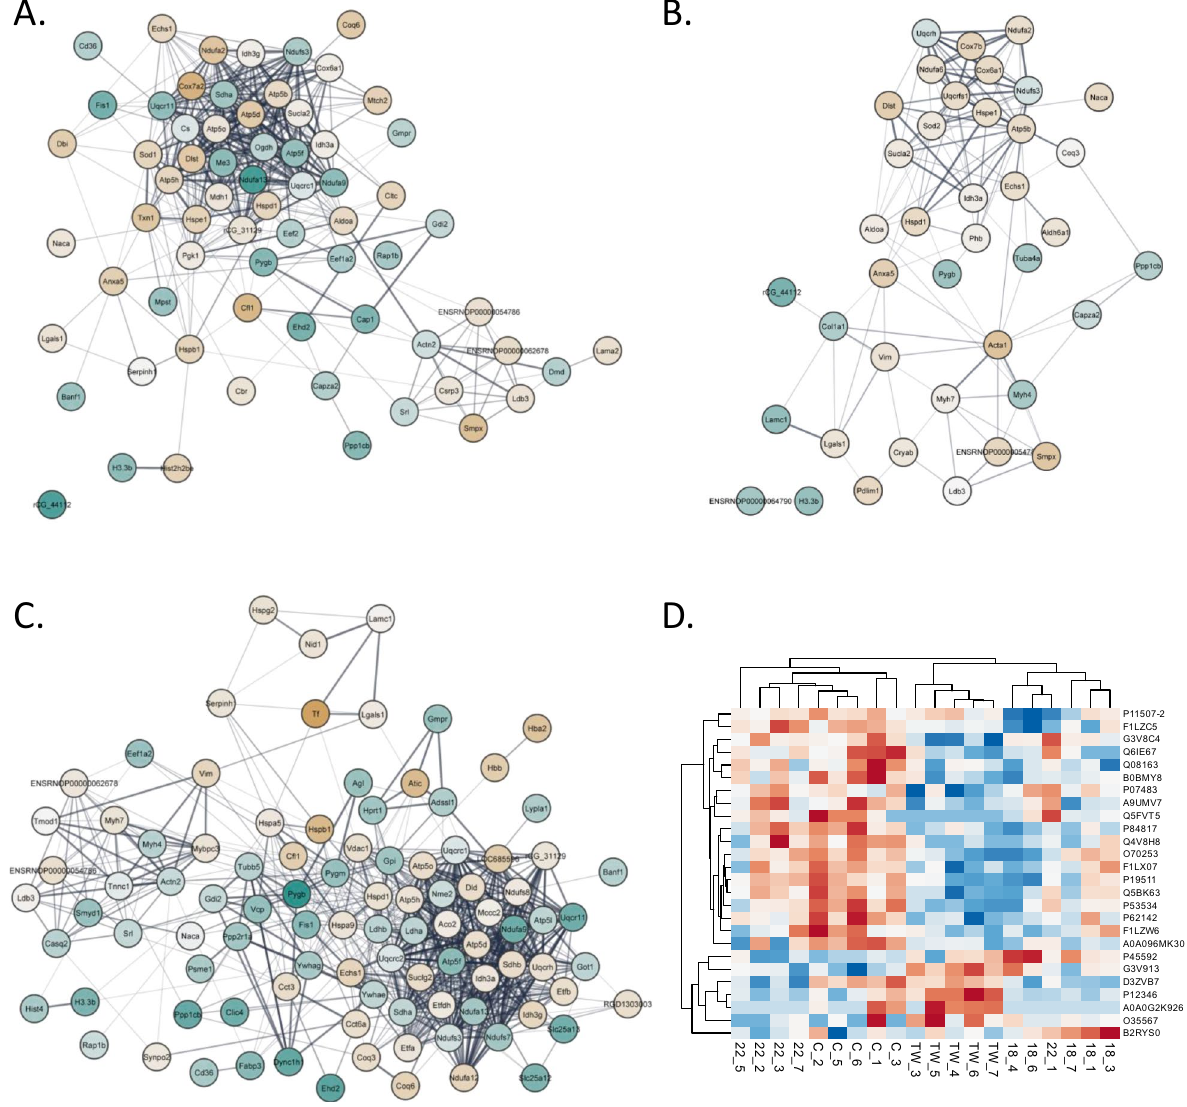
Figure 2. ( A – C ) Interaction networks of proteins with statistically significant changes in concentration in each comparison: ( A ) 1.8 for to control group, ( B ) 2.2 for to control group, and ( C ) TW for to control group. Node color designates the direction and extent of the concentration fold change: gold—FC > 1, blue—FC < 1. Node edges designate association with mitochondrion (red) or muscle structure/contraction (green). ( D ) Heatmap of median protein concentrations in samples for proteins with a statistically significant twofold or higher concentration change in at least one of the considered comparisons to the control group ( p value < 0.05 in a